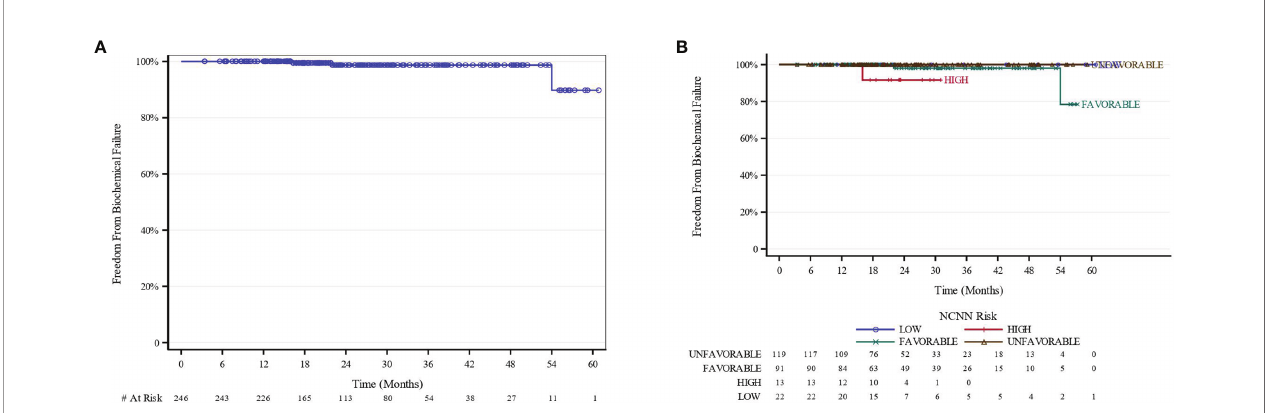
FIGURE 2 | BFFS Kaplan-Meier curves (A) All patients. (B) Strati fi ed by NCCN Risk. BFFS of 100% and 98.7% at 1 year and 2 years, respectively. BFFS of 100% for LR, 98.1% for favorable-intermediate, 100% for unfavorable-intermidiate, and 91.7% for HR patients at 2 years. Because no biochemical events were reported in the “ low-risk ” and ‘ unfavorable-intermediate risk ” NCCN risk group, they were excluded from analysis. BFFS, biochemical failure-free survival; NCCN, National Comprehensive Cancer Network.